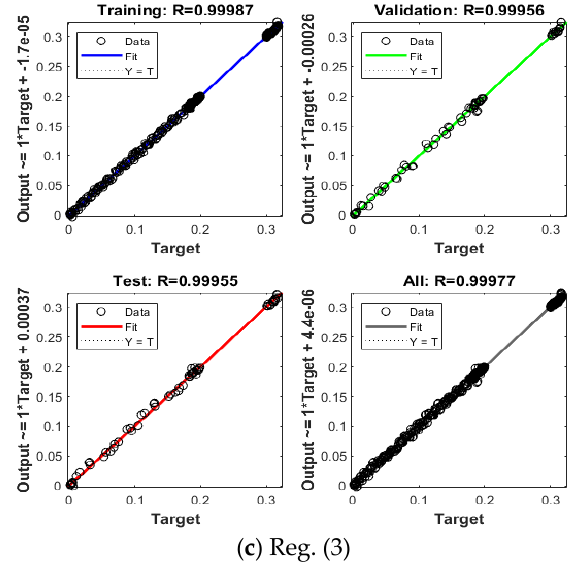
Figure 7. Reg performances for each case of the MTS. The comparison performances of each dynamic of nonlinear MTS are presented in Figure 8. The overlapping of the obtained and reference results was accomplished for each dynamic of the MTS, which represents the correctness of the stochastic RB-SCGDNN scheme.